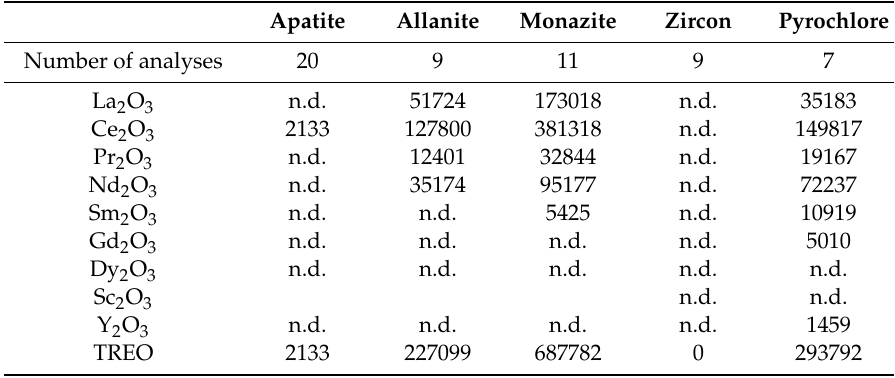
Table 7. The individual concentrations of REEs in all the REE-bearing phases: apatite, allanite, monazite, zircon and pyrochlore by EPMA (mg / kg) (measured by REOs). Apatite Allanite Monazite Zircon Pyrochlore Number of analyses